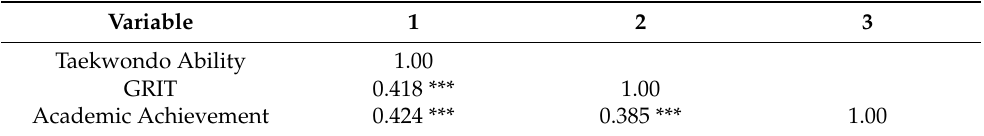
Table 2. Correlations of participants’ taekwondo ability, GRIT, and academic achievement n = 204.